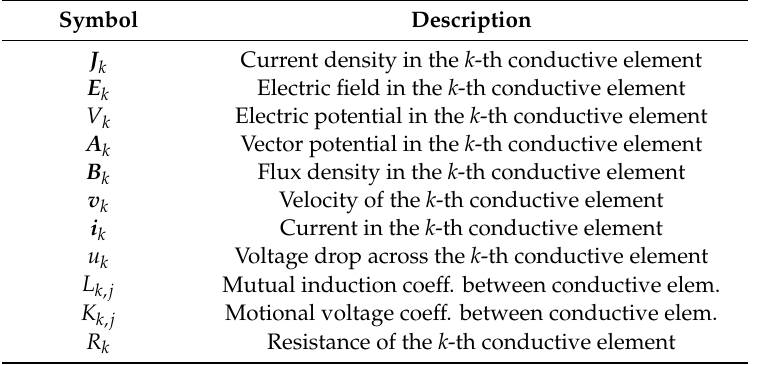
Figure 1. Conceptual flow chart of the numerical formulation. (Reproduced with permission from [30], IEEE, 2017). Table 1. Notations.